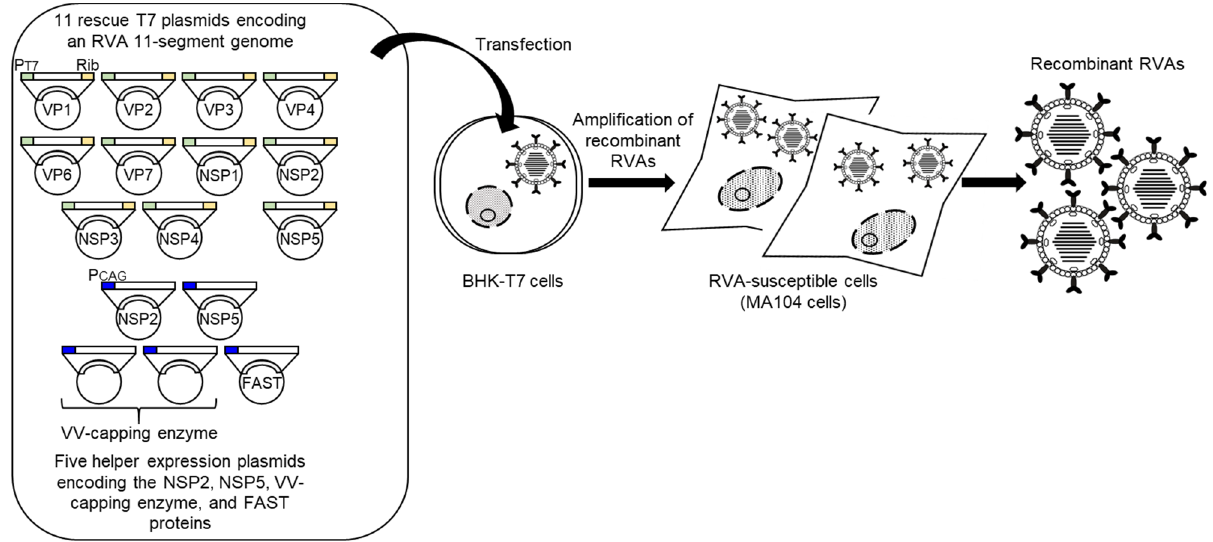
Figure 3. Schematic representation of Kawagishi’s reverse genetics system. BHK-T7 cells are transfected with a set of 11 rescue T7 plasmids encoding an RVA genome as well as five helper expression plasmids for the NSP2, NSP5, VV-capping enzyme, and small membrane fusion proteins. After 2 days, the transfected BHK-T7 cells are overlaid with RVA-susceptible cells (MA104 cells) and then co-cultured for 5 days for amplification of recombinant RVAs. Recombinant RVAs can be rescued from the co-cultures. PT7, Rib, PCAG, and FAST denote the T7 RNA polymerase promoter sequence, HDV ribozyme sequence, CAG promoter sequence, and small membrane fusion protein, respectively.